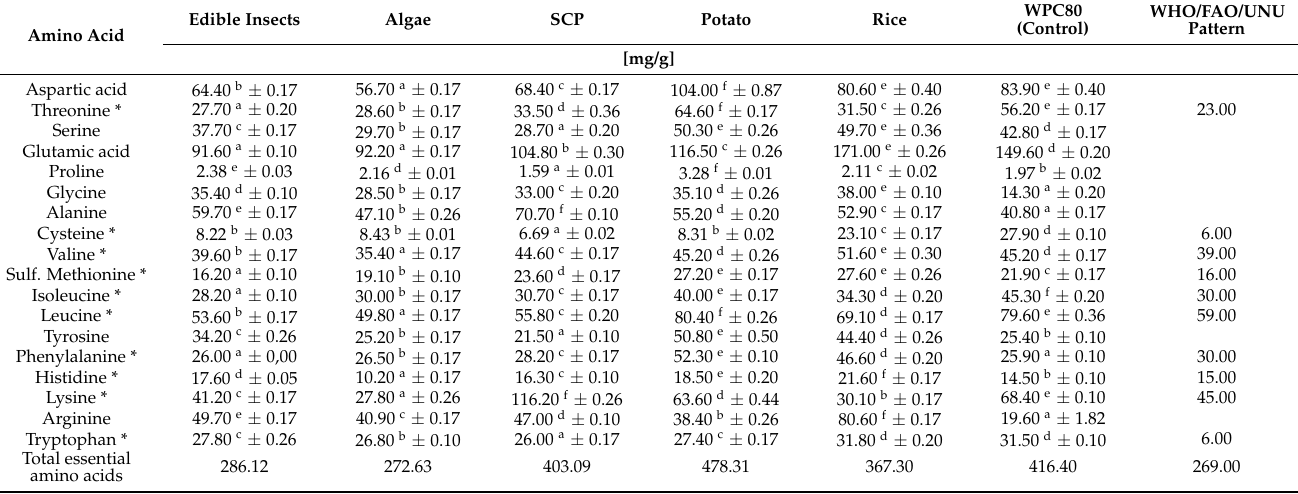
Table 2. Amino acid composition of protein samples and amino acid composition pattern according to FAO/WHO/UNU [40]. Different letters (a–f) in the same row indicate a significant difference at p <